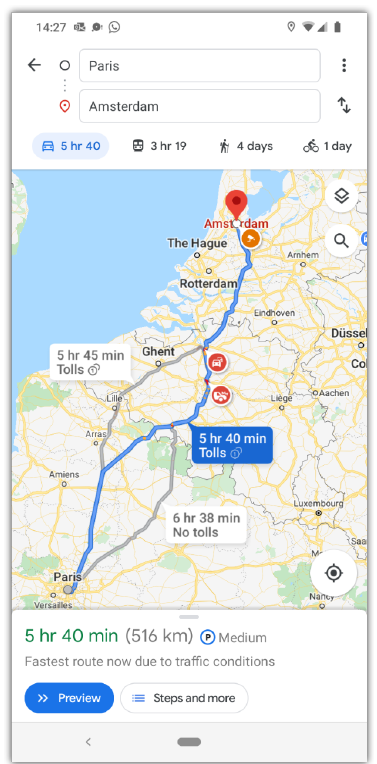
Figure 5. A screen capture from a smartphone of the Google Maps Android app, showing possible driving routes between Paris and Amsterdam, taken 14 February 2020. Routes shown in an overview such as this one are necessarily simplified from their full-resolution, turn-by-turn data.